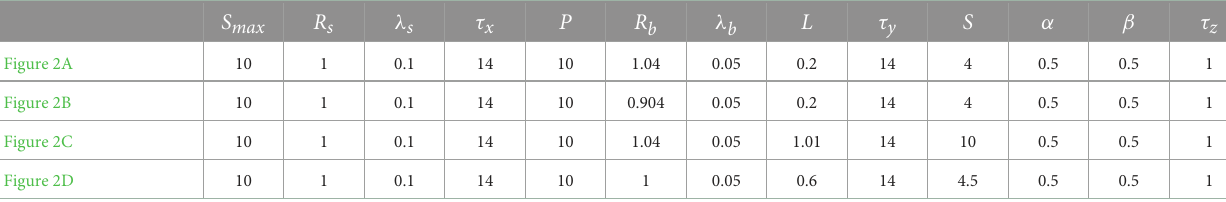
Forallsimulations λ f = 1and τ f =